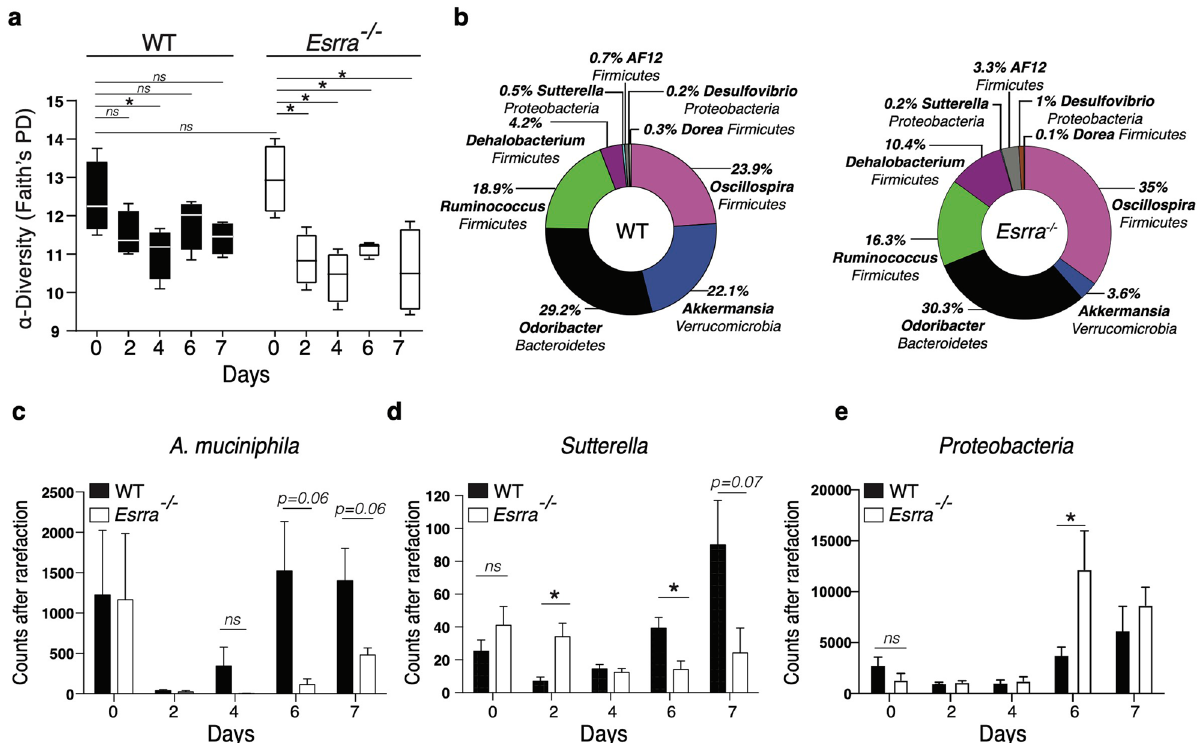
Figure 3. ERRα deficiency leads to alterations in fecal microbiota diversity and composition. ( a ) Analysis of the microbiome alpha diversity in the fecal pellets of WT mice or Esrra −/− mice collected at baseline (day 0—untreated) or at different time points after 3% DSS treatment. Kruskal–Wallis for all groups, p < 0.01. ( b ) Bacterial genera (the phylum name is indicated under the genus name) with significant differences in abundance levels (ANCOM test) in the fecal pellets of WT mice versus Esrra −/− mice, day 6 is illustrated. Differences in operational taxonomic units (OTUs) between WT and Esrra −/− mice at different time points in the DSS experiment in Akkermansia muciniphila ( c ), Sutterella ( d ), and Proteobacteria ( e ). Data represent the mean ± SEM of n = 4 mice/genotype. Statistical analysis was performed using Student’s t -test, *p < 0.05. ns, not